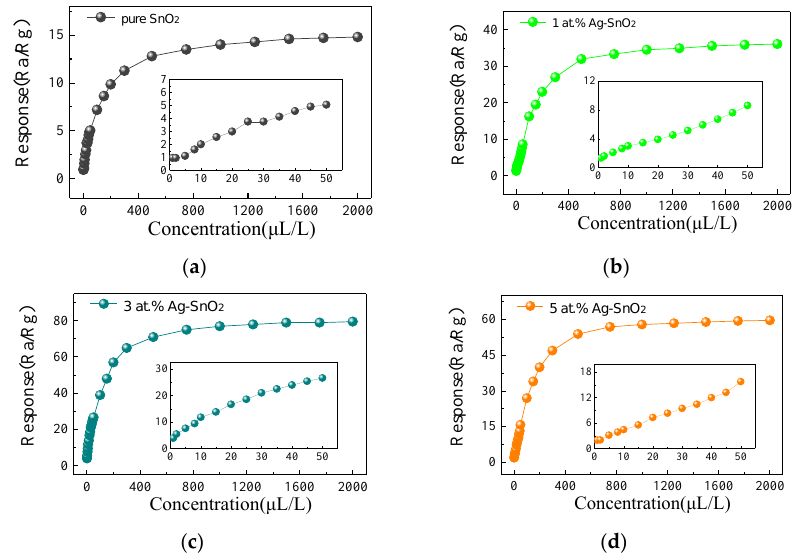
Figure 7. Gas responses of pure,1 at.%,3 at.% and 5 at.% Ag-doped SnO 2 based sensor versus different concentration of H 2 under their optimum operating temperature. ( a ) Pure; ( b ) 1 at.% Ag-doped SnO 2 ; ( c ) 3 at.% Ag-doped SnO 2 ; ( d ) 5 at.% Ag-doped SnO 2 .